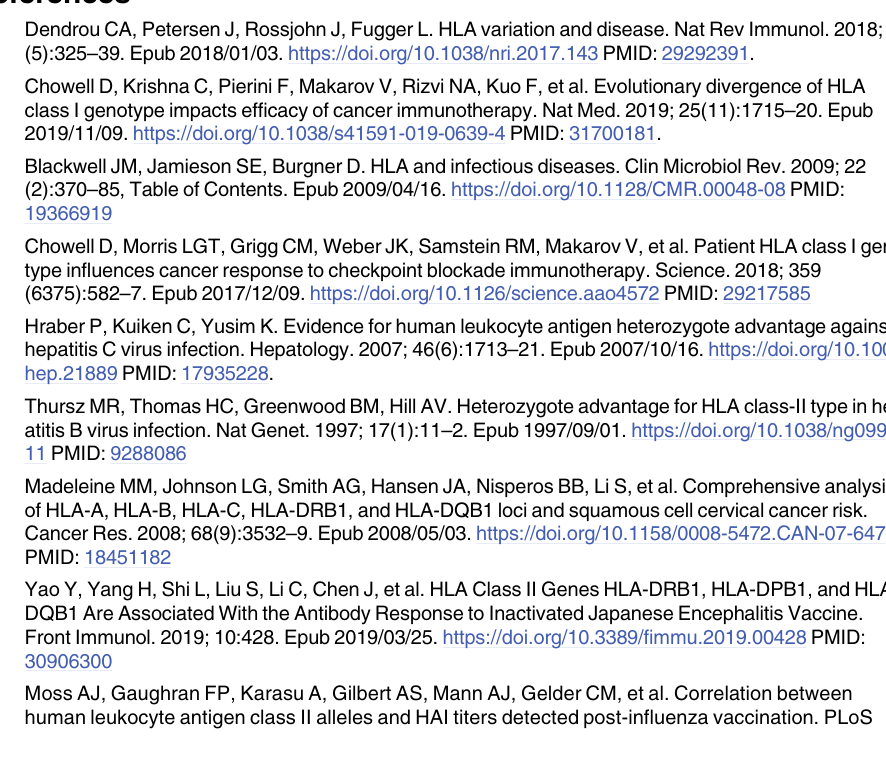
S2 Table. Epitope ranking and excision results for HLA-DR, IAd (NetMHC), IAd (SMM), and IEd (SMM)